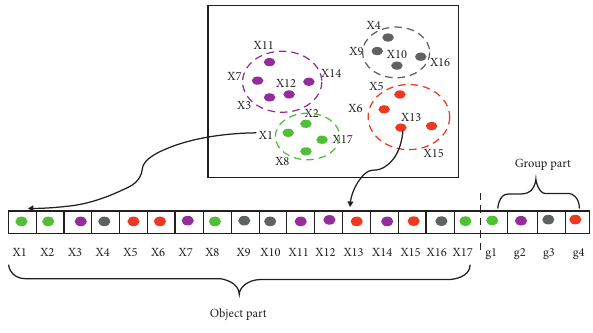
Figure 7: Error parameter influence diagram. Table 2: Correlation between various